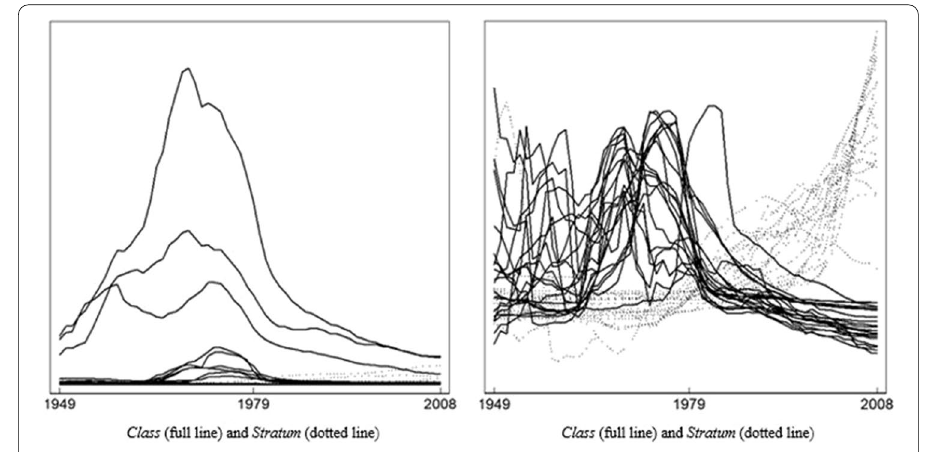
Fig. 2 The trend of Class and Stratum (all words’